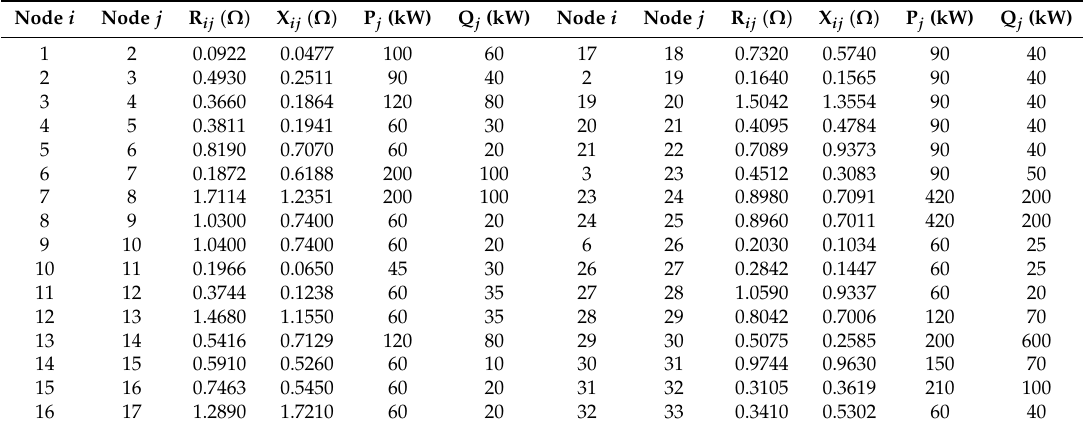
Figure 3. IEEE 33-node test feeder topology. Table 2. The IEEE 33-node test feeder